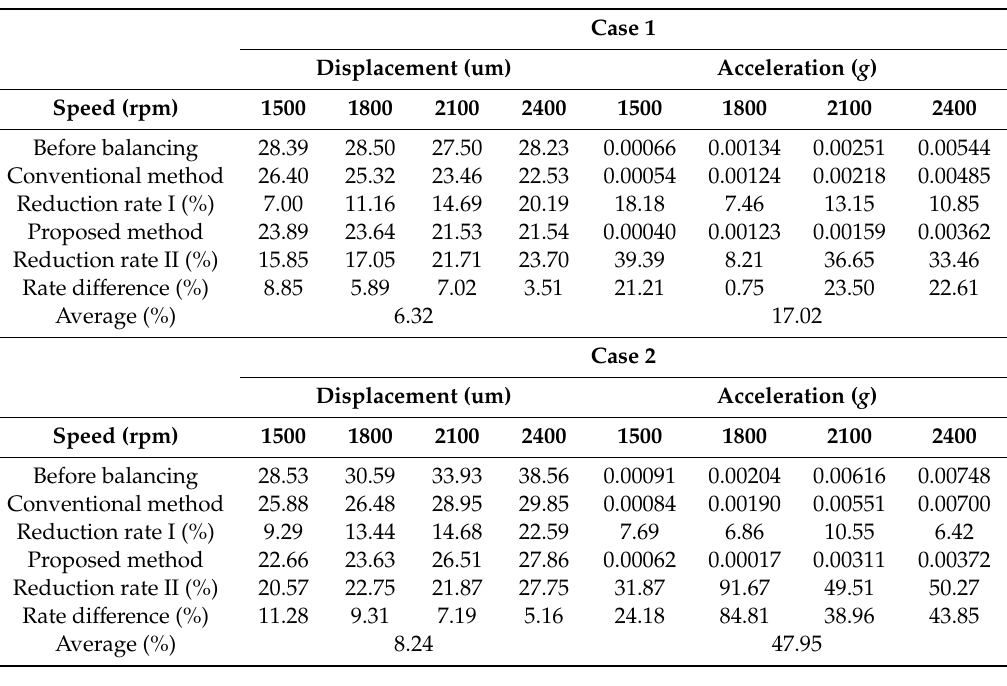
Figure 7. Balancing results for Case 2: ( a ) #2 displacement sensor; ( b ) #2 acceleration sensor. Table 6. Vibration reduction rate using the proposed method compared to conventional